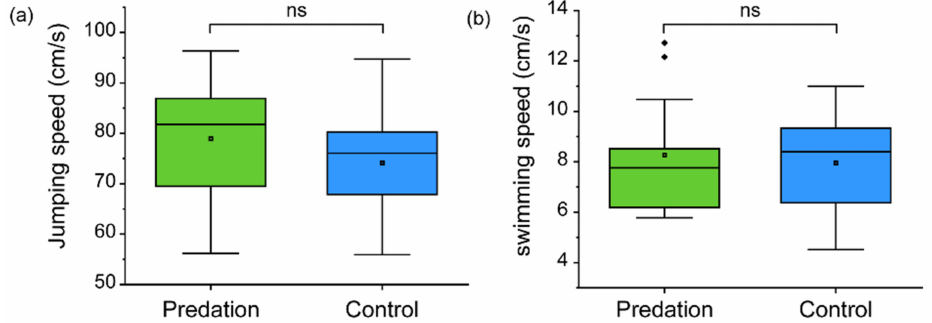
Figure 6. Comparison of the ( a ) jumping and ( b ) swimming speeds in juvenile frogs (Gosner stage 46) between the predation and control groups. The green and blue boxes represent the tadpoles from the predation and control groups, respectively. The box plots show the: mean (central square dot); median (central band); 25th and 75th percentiles (the bottom and top of the boxes); range within the 1.5 interquartile (the bottom and top of the line); and outlier (diamond